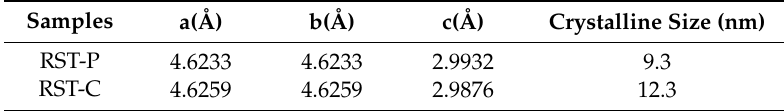
Table 2. Rietveld refinement of the XRD